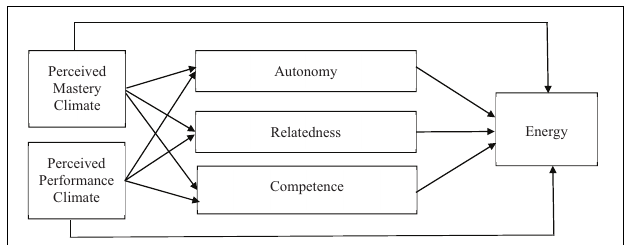
FIGURE 1 | Conceptual